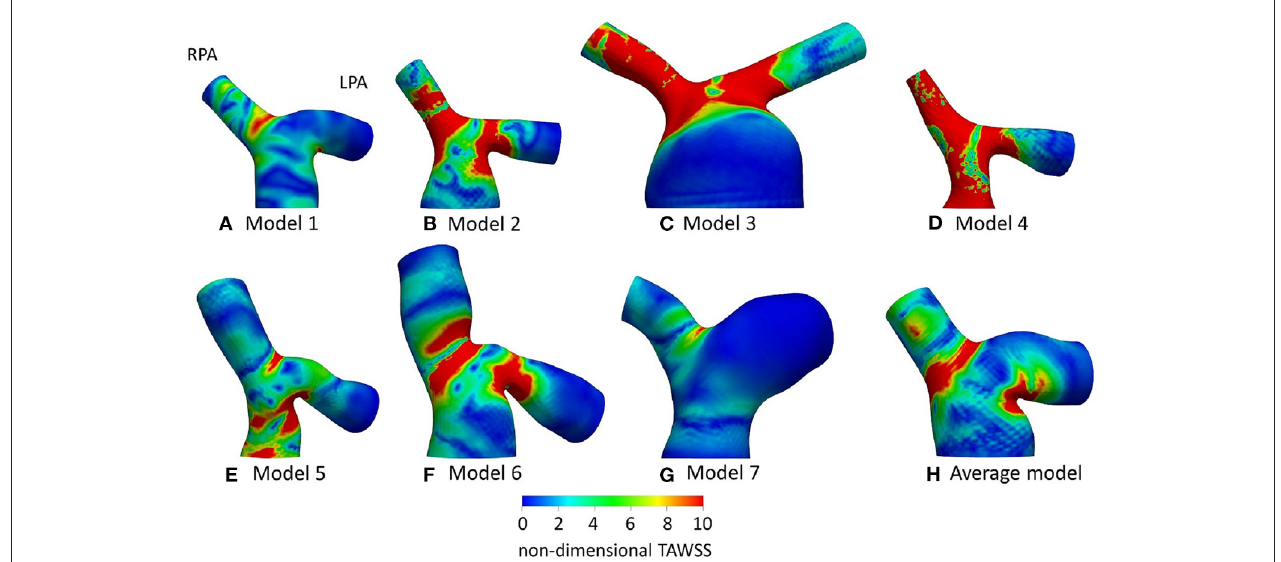
FIGURE 6 | Non-dimensionalized time-averaged wall shear stress (TAWSS n ) distribution, normalized with the corresponding value at the inlet of each models, for (A) Model 1; (B) Model 2; (C) Model 3; (D) Model 4; (E) Model 5; (F) Model 6; (G) Model 7; and (H) Average model. Averaged boundary conditions are used at the inlet and the outlets of all